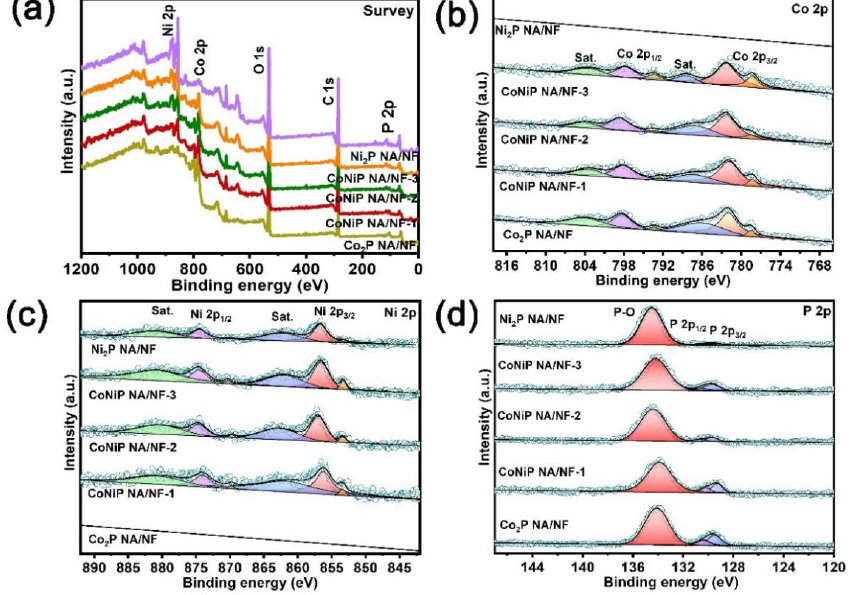
Figure 4. ( a ) XPS survey spectra of CoNiP NA/NF-1, CoNiP NA/NF-2, CoNiP NA/NF-3, Co 2 P NA/NF and Ni 2 P NA/NF. ( b ) High-resolution XPS spectra of ( b ) Co 2p ( c ) Ni 2p and ( d ) P 2p of samples.